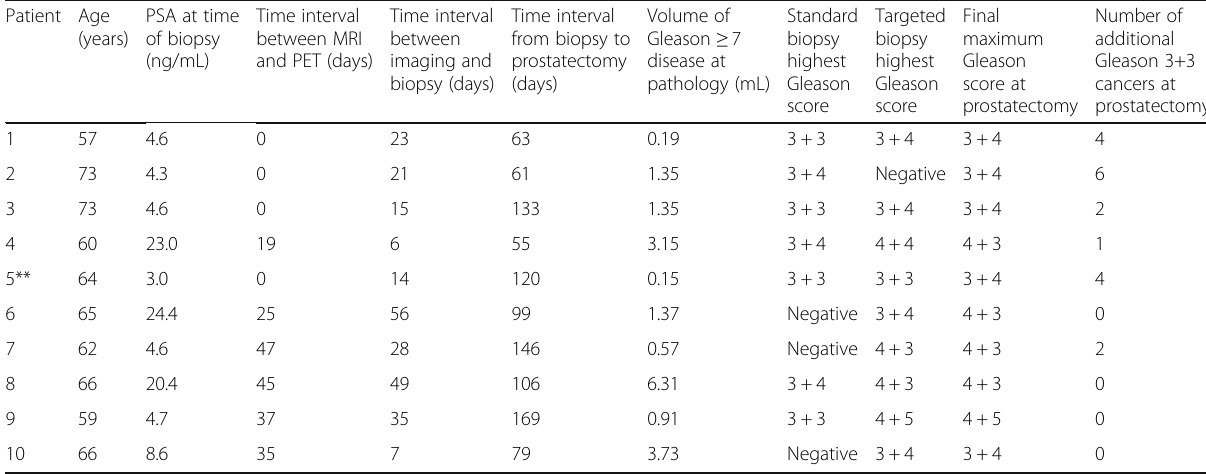
Table 1 Patient characteristics Patient Age PSA at time (years) of